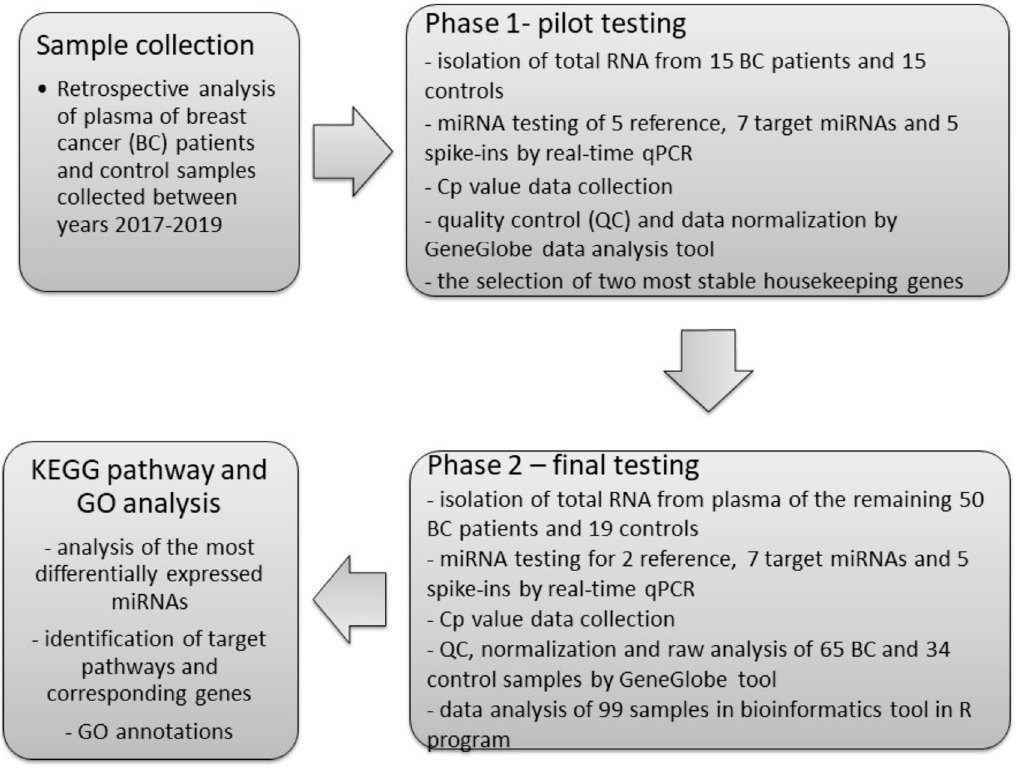
Figure 1. The scheme of study design.